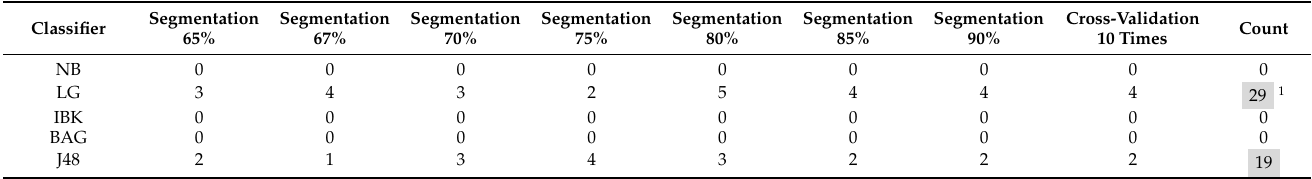
Table 20. The statistical results of best classifier for samples in the five ratio groups with no-feature selection from Tables 5, 7, 9, 11, and 13.